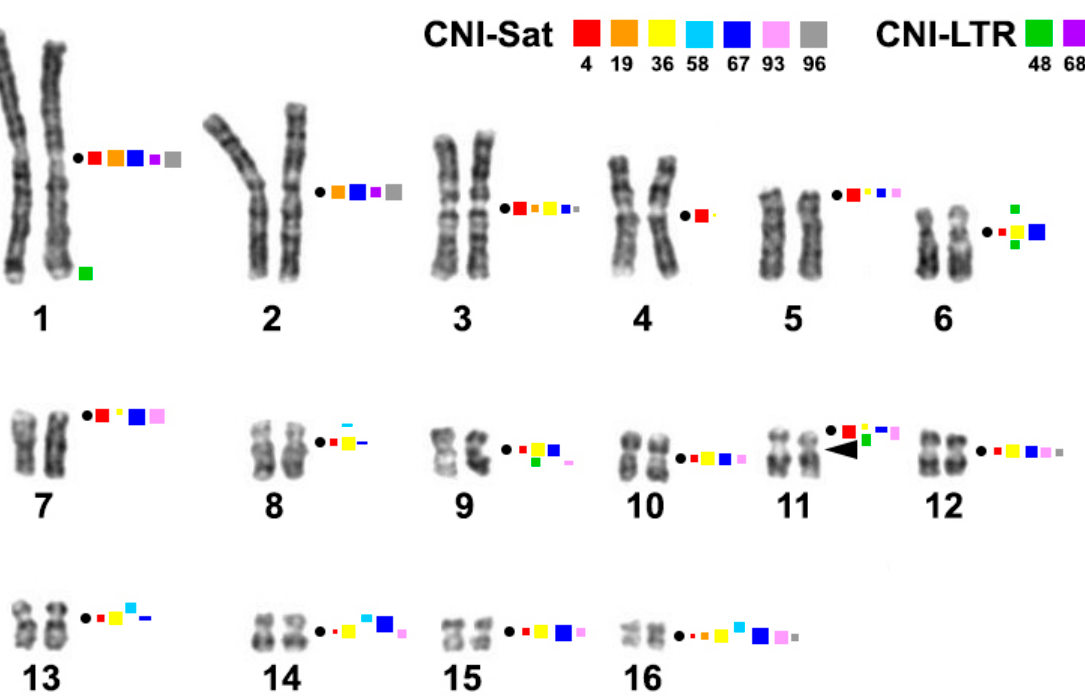
Figure 4. Repetitive DNA probe location on the GTG-banded Crocodylus niloticus karyotype. Each cluster of repeated sequences has its own color code (shown in the upper figure right corner). The sizes of the squares roughly show signal intensity. The black arrow marks the region of 18S/28S-rDNA probe localization. The black dots mark the positions of centromeres.